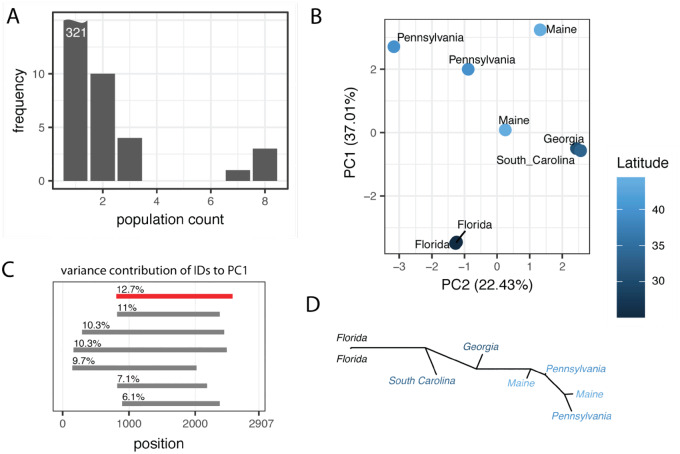
IDs of the P-element recover the latitudinal cline found in Drosophila melanogaster populations from the East Coast of the United States (Bergland et al. 2014). (A) Distribution of IDs in the populations. Most IDs (321) are only found in a single population, whereas three are found in all eight populations. (B) PCA based on the frequency of IDs, with PC1 being correlated with latitude (ρ=0.86, P = 0.0061). (C) Variance contribution of the most important IDs to PC1. The start and end positions of IDs (line) as well as the variance contributions of IDs are shown. The KP-element is shown in red. (D) Unrooted tree based on the genetic distance of the ID fingerprints. A latitudinal cline can be observed along the tree.